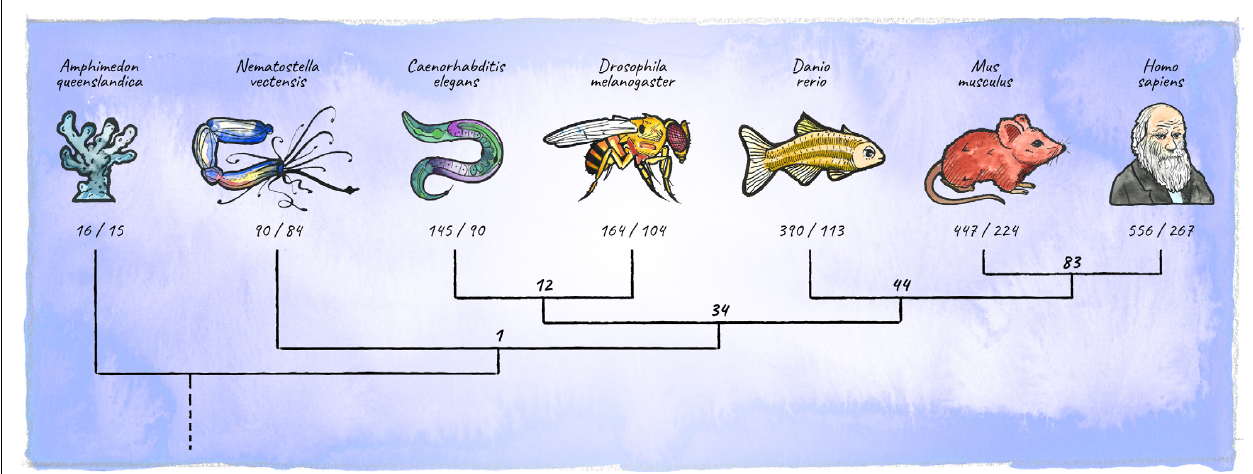
FIGURE 5 | Diversification of the metazoan miRNA repertoire. Shown are numbers of individual miRNAs/miRNA-families (in bold) annotated with high confidence for various clades (https://mirgenedb.org, Fromm et al., 2020). Number of miRNA families present in the last common ancestors of branching clades are noted above the split. Exemplary organisms depicted are Amphimedon queenslandica , Nematostella vectensis , Caenorhabditis elegans , Drosophila melanogaster , Danio rerio , Mus musculus , and Homo sapiens . Data for bilateria is derived from Fromm et al. (2020), for Amphimedon and Nematostella numbers were retrieved from the work of Grimson et al. (2008); Moran et al. (2014), and Calcino et al.